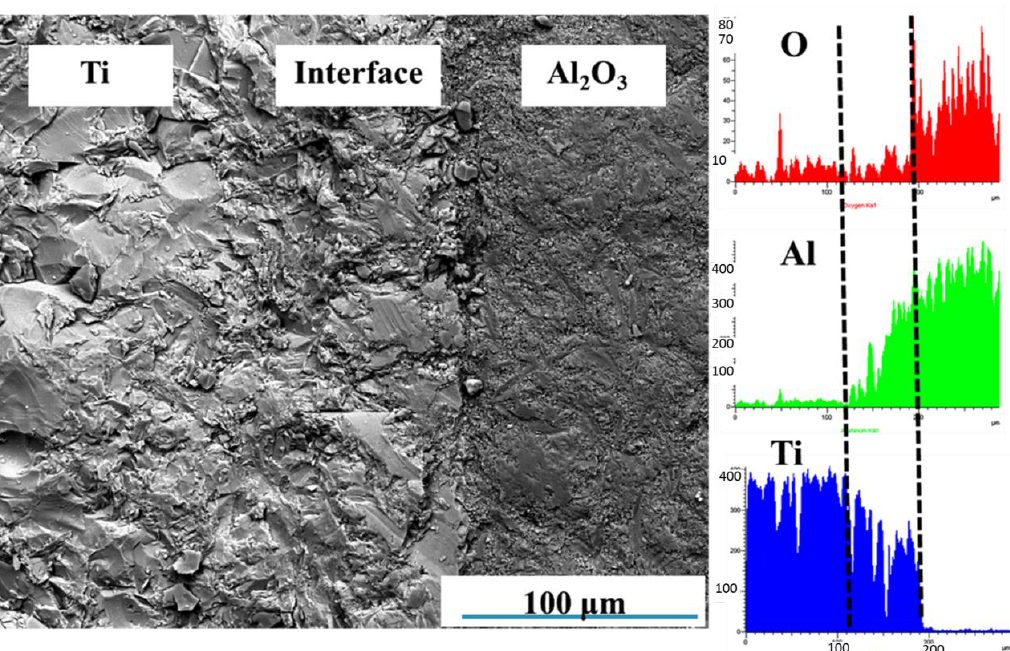
Figure 2. Scanning electron microscopy (SEM) images and line scanning analysis of the interface at 1250 °C holding for 1.5 h.